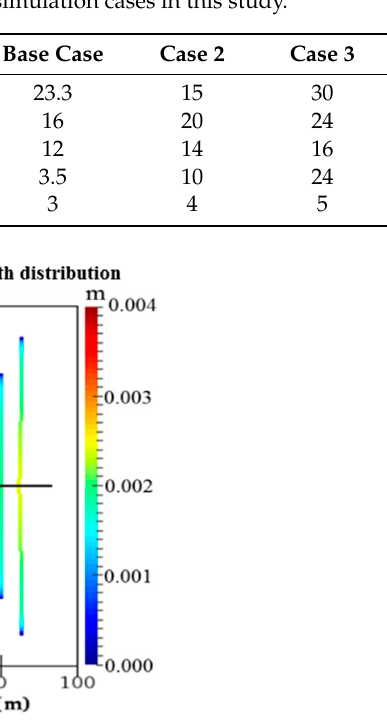
Figure 2. Three transverse fractures propagating simultaneously in a single stage.